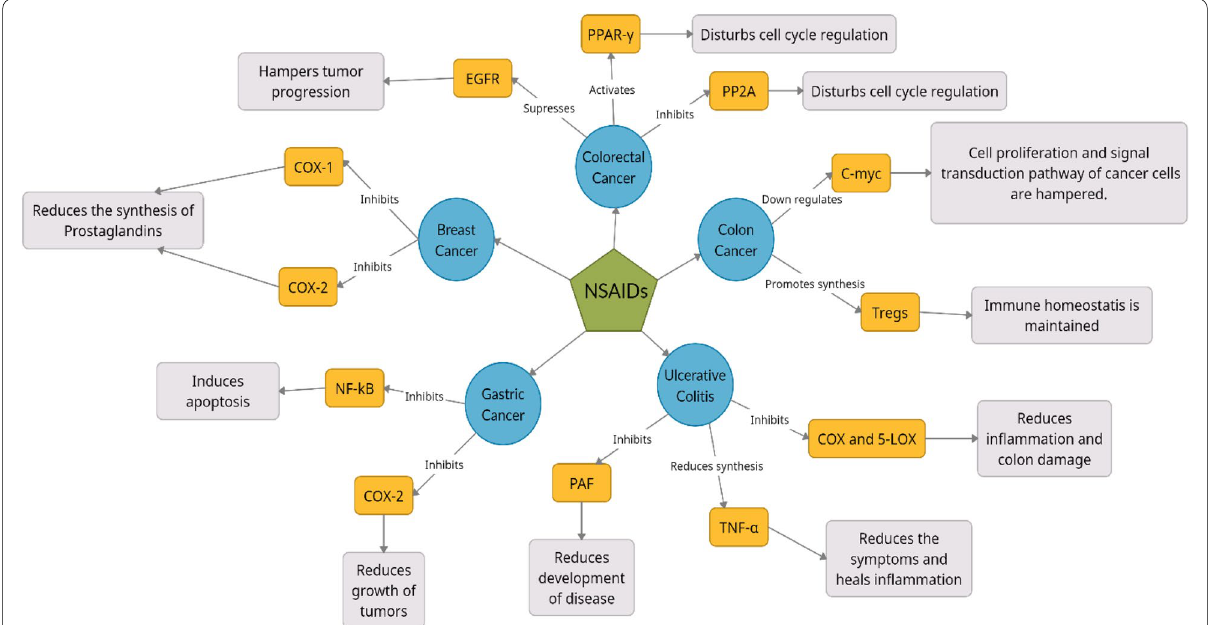
Fig. 2 Schematic representation of various action of NSAIDs through different targets and its consequences in various conditions and cancer types. NSAIDS have been known to inhibit NF-KB, COX-1, COX-2, 5 LOX, PAF, and PP2A respectively, and supress EGFR in different cancer